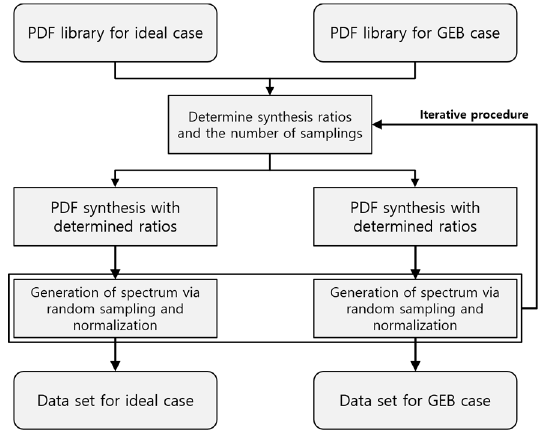
Figure 3. Flow chart of dataset generation.